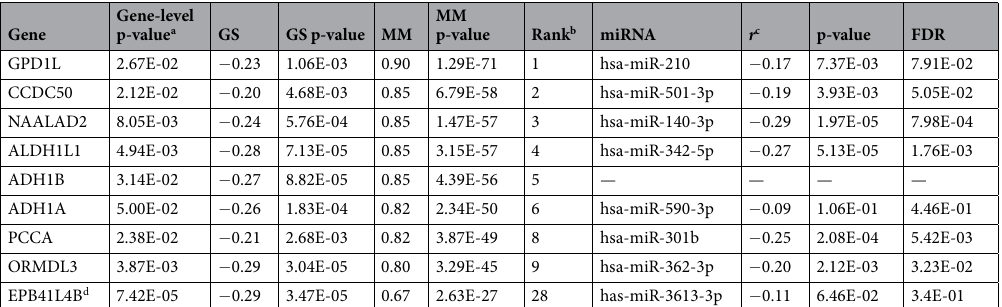
Table 1. Hub genes in the Yellow module. GS, gene significance; MM, module membership. a Gene-level p-value generated by ProxyGeneLD in the GIANT GWAS. b Rank based on MM. c Correlation betwwen miRNA and mRNA. For gene ADH1B, there was no predicted miRNA-mRNA target pair in the MicroCosm database. d One of 97 BMI loci identified by